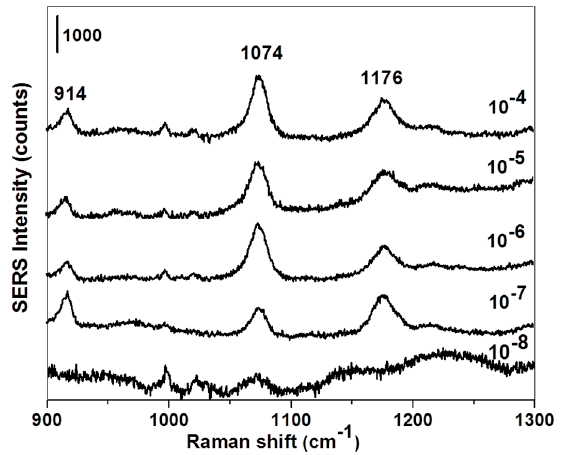
Figure 3. Representative surface-enhanced Raman scattering (SERS) spectra for p-MBA solutions at different concentrations (10 − 8 –10 − 4 mol L − 1 ). Laser wavelength: 633 nm; laser power: 2.5 mW. The spectra were normalized and the scale bar is 1000 count.